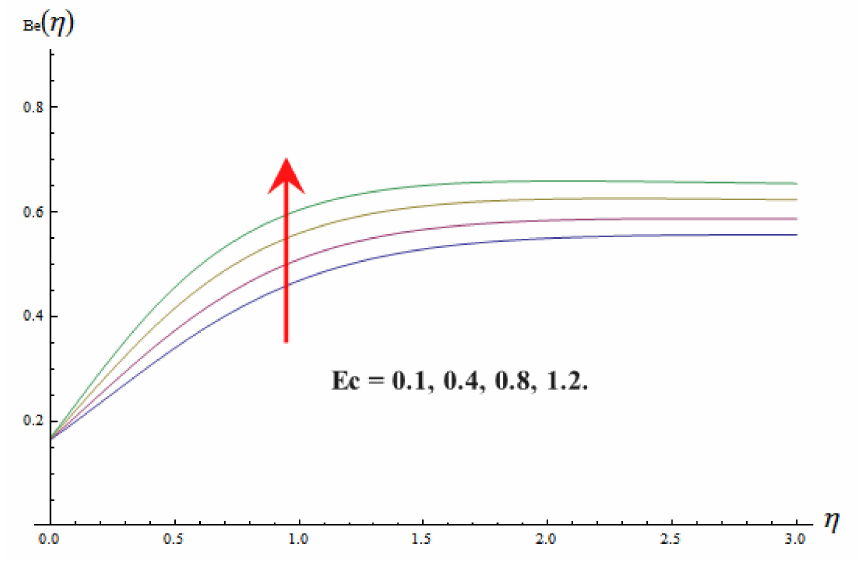
Figure 16. Impact of Ec on Be ( η ) keeping Pr = 0.5, Ha = 0.2, Γ = 0.2, λ = 2, Br = 2, Rd = 2, β 1 = 0.2, λ 1 = 0.2, K ∗ =